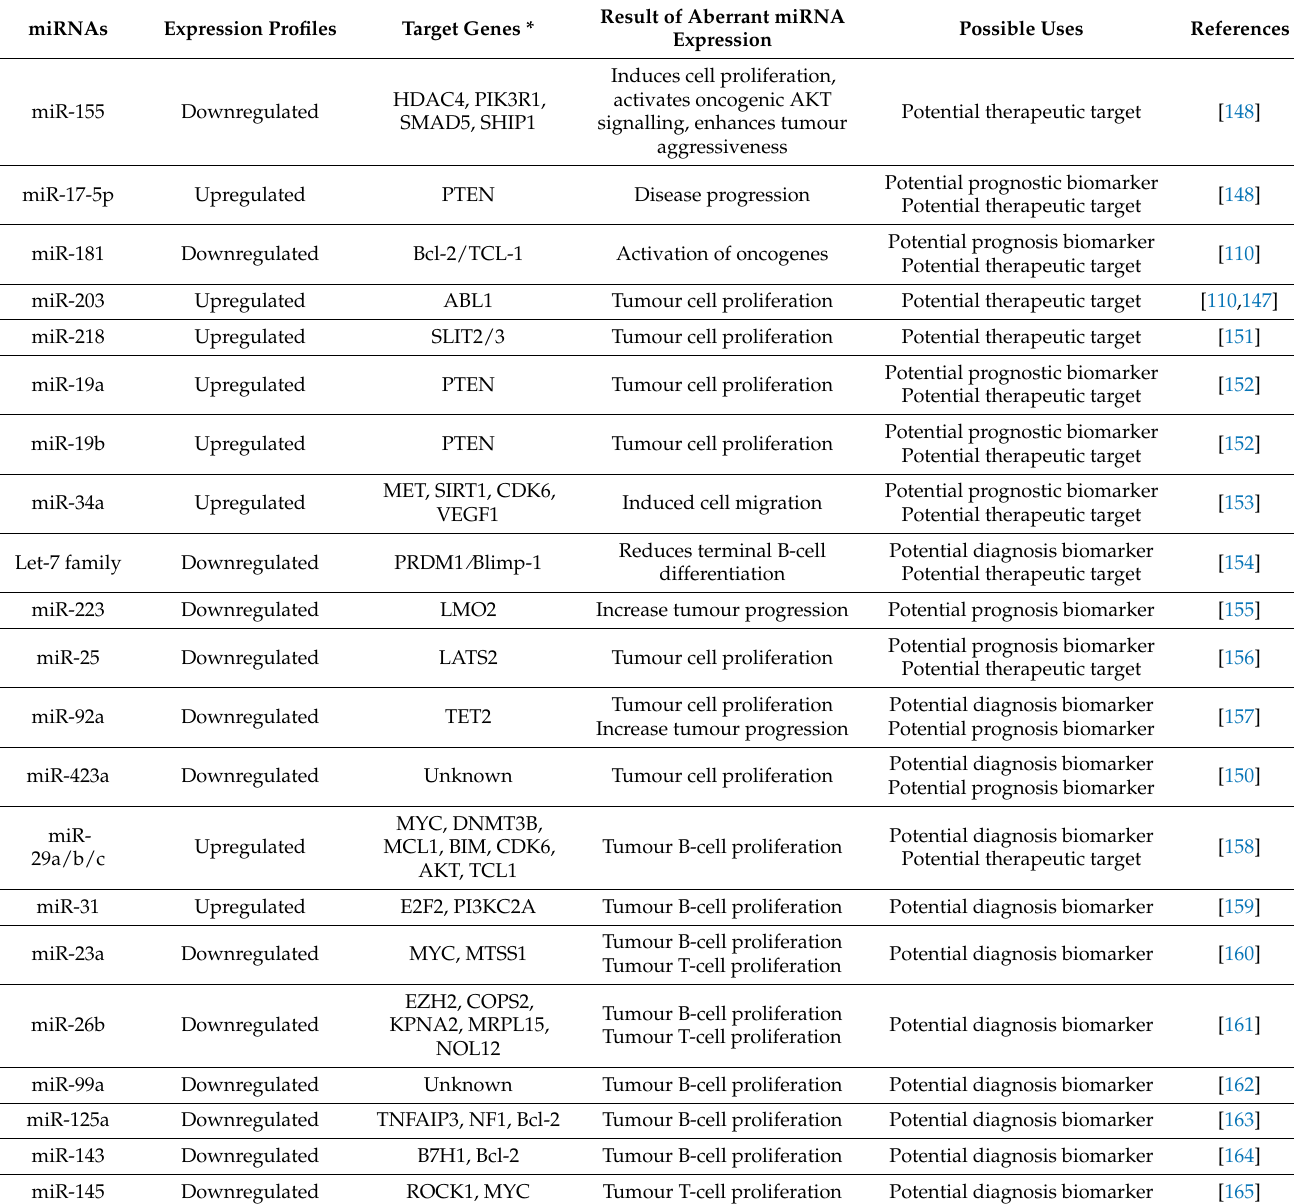
Table 2. MicroRNAs (miRNAs) related to canine malignant lymphoma (CML), target of these miRNAs, result of aberrant expression and possible